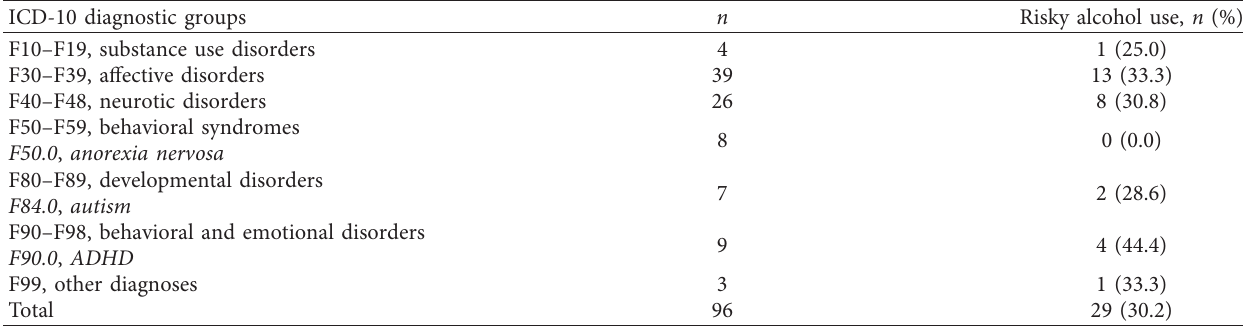
Table 3: Distribution of psychiatric ICD-10 main diagnoses in correlation to risky alcohol use.